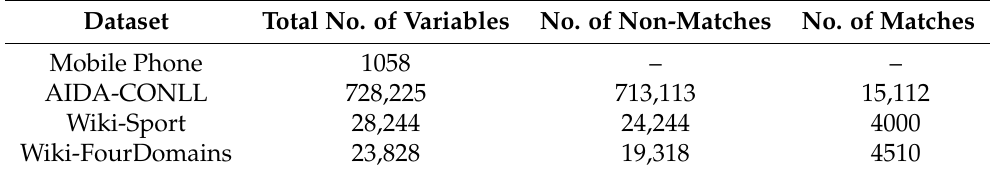
Table 2. Statistics of the test datasets.